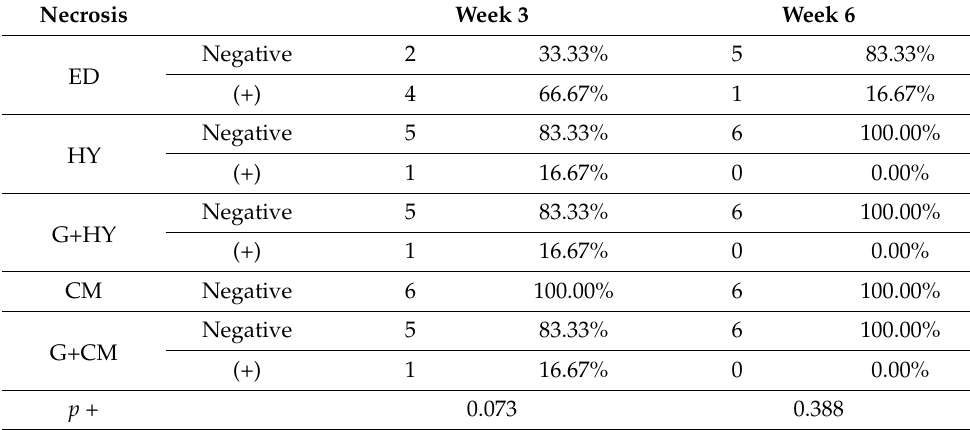
Table 2. Necrosis scores in the 3rd and 6th weeks. A chi-square test was